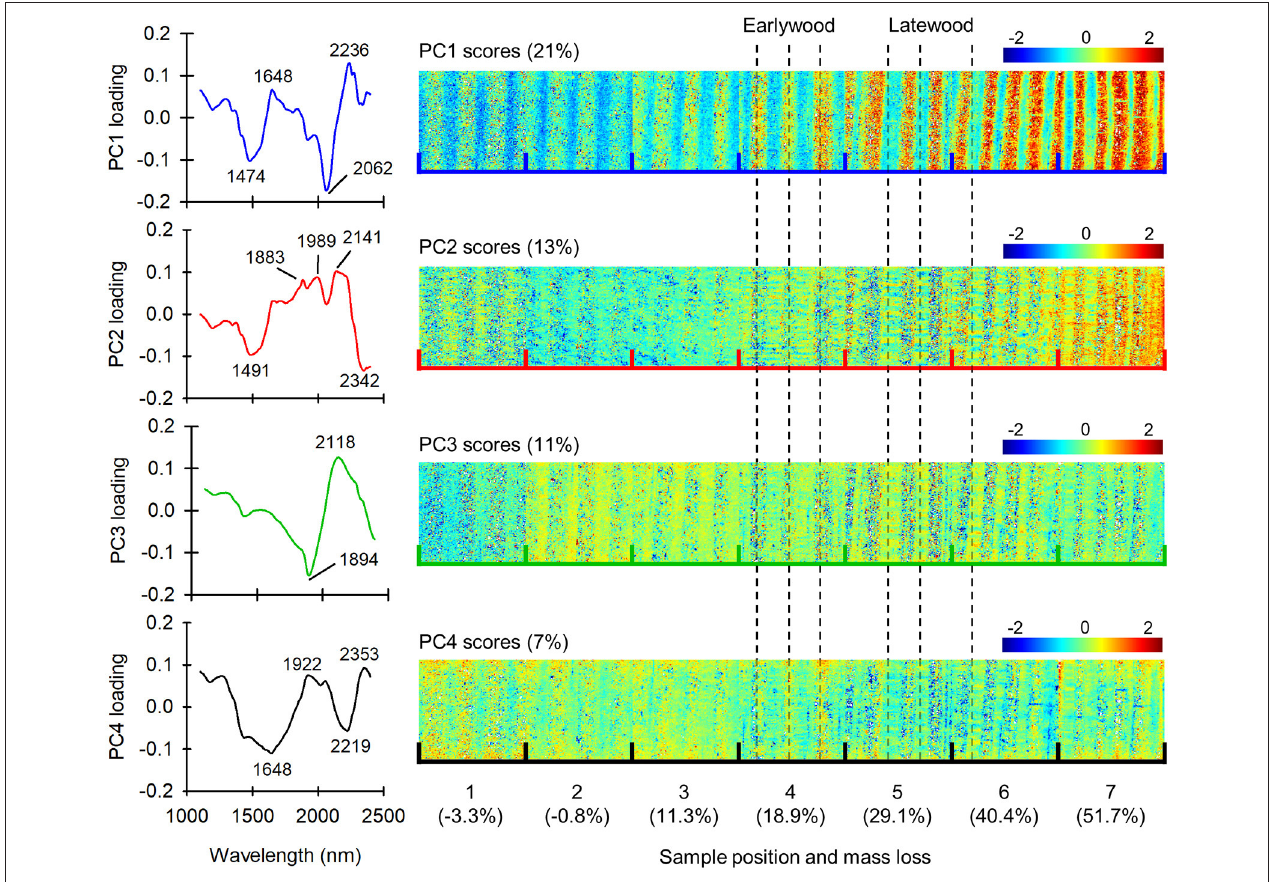
FIGURE 4 | Loadings and scores of PCs 1–4 in a set of samples exposed to C. puteana . Each individual image in the score mosaics is sized 7.3 ×